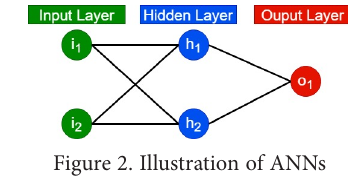
Figure 2. Illustration of